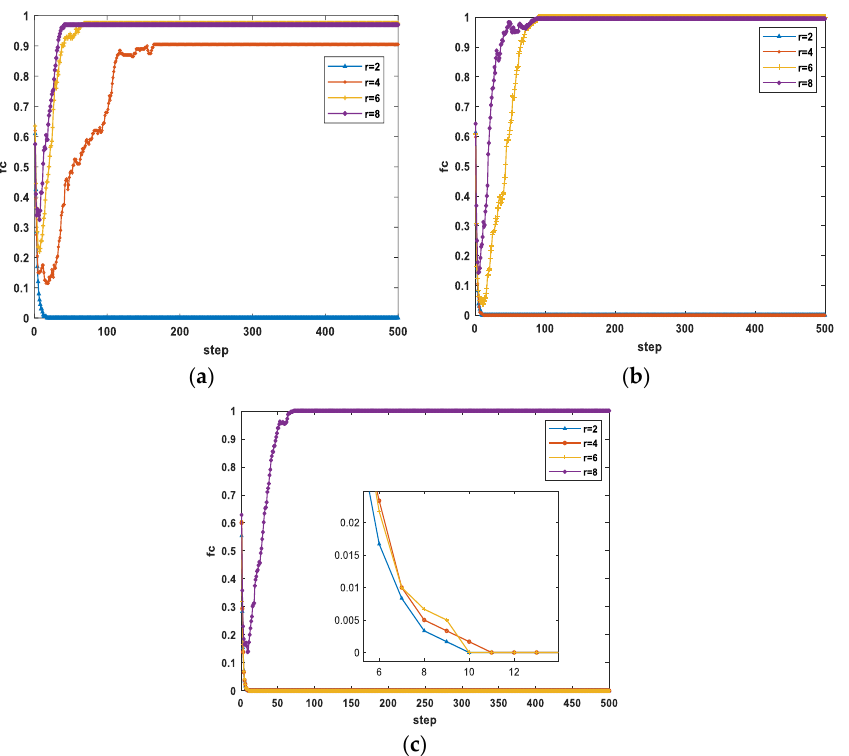
Figure 8. Relationship between population density and cooperative evolution: ( a ) ρ = 2, ( b ) ρ = 4, and ( c ) = 6.